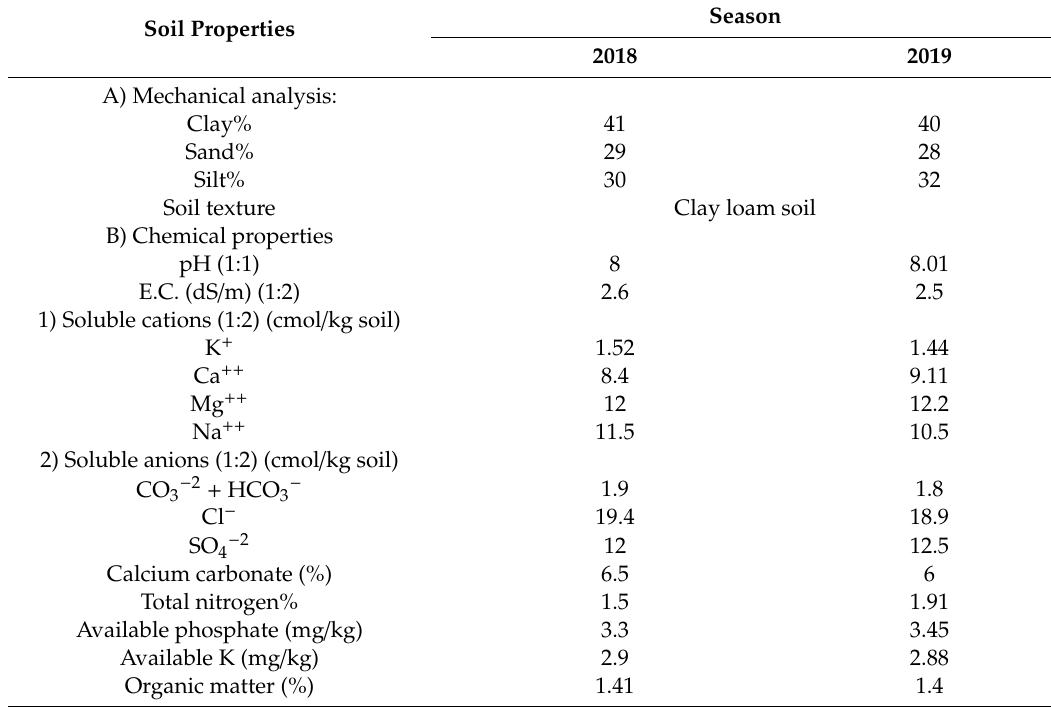
Table 1. Soil physical and chemical properties during both